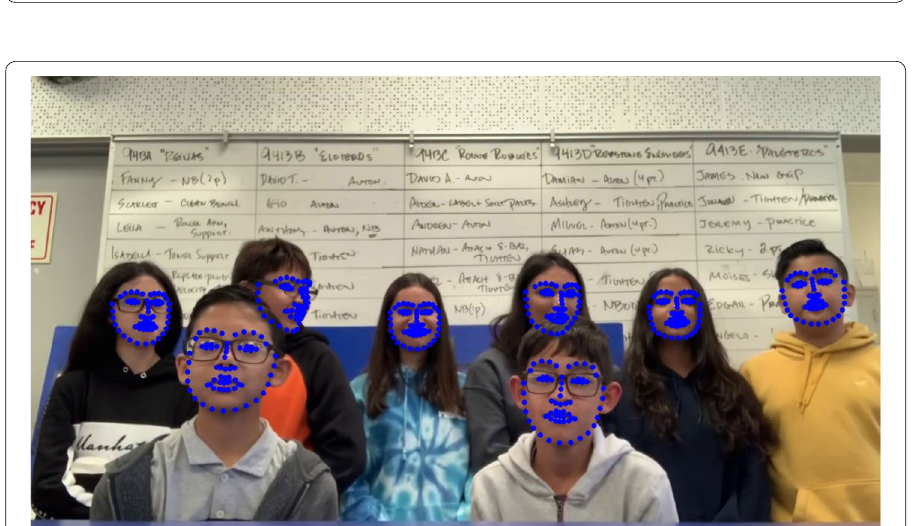
Fig. 2 Input video